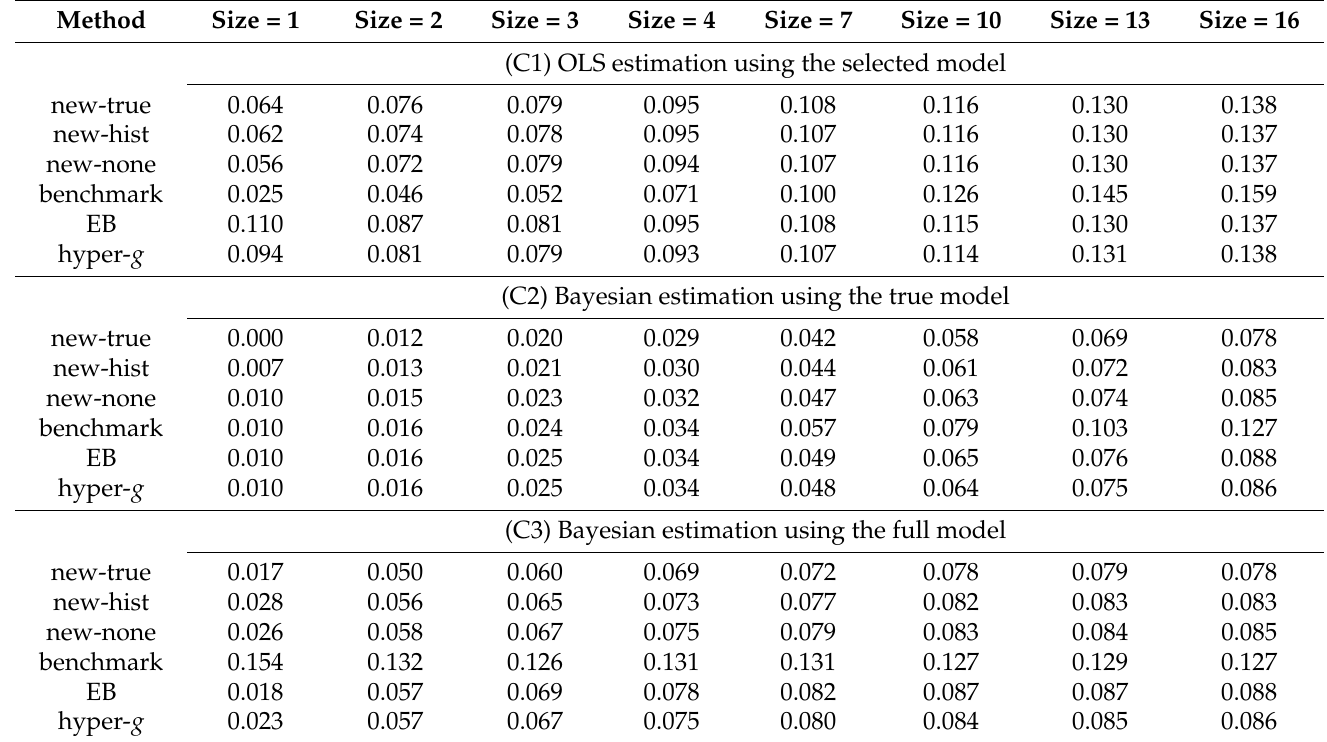
Table 2. Simulation I: Average (cid:107) X β − X ˆ β (cid:107) 2 / n values across 200 MC replicates in the simulation study for variable